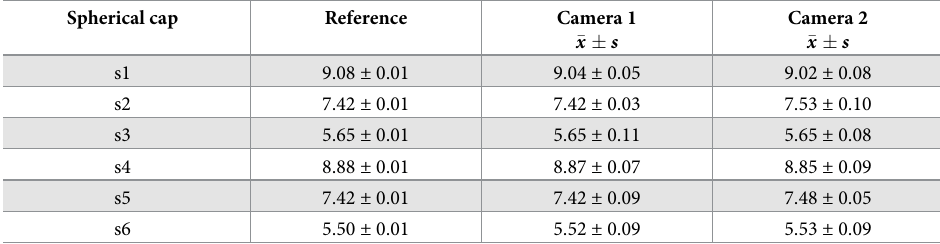
Table 1. First validation experiment. Measured diameters for six spherical caps with a caliper (Reference measure- ment) and the 3D imaging system (using camera 1 and camera 2). All values in millimeters.